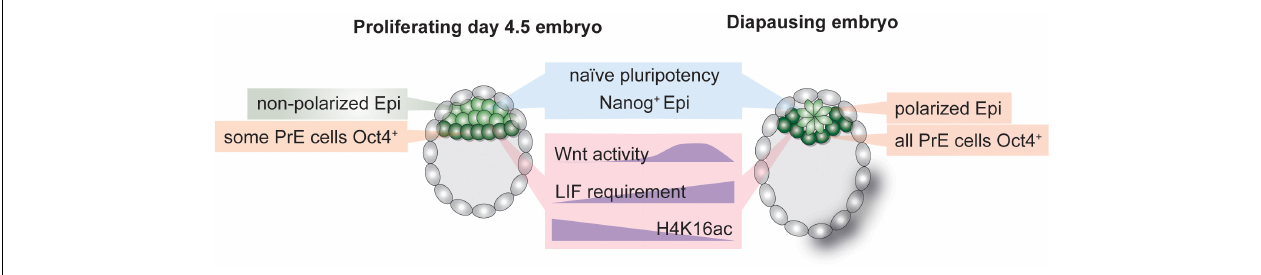
FIGURE 3 | Hallmarks of the inner cell mass (ICM) of normal and diapause blastocysts. Establishment and maintenance of diapause entails alterations in cellular signaling pathways, transcriptional networks and the chromatin state. The epiblast retains naïve pluripotency during diapause but is polarized due to transient Wnt pathway activity. LIF is required to sustain the epiblast throughout diapause. The transcription-associated histone H4K16 acetylation is depleted in diapause